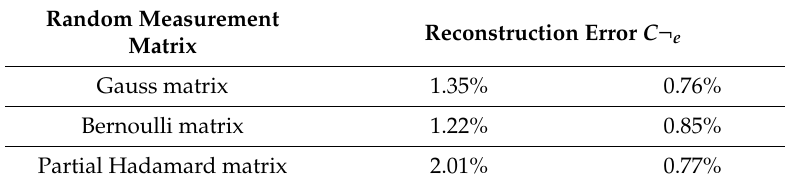
Table 1. The reconstruction error of IGBT switching signal with di ff erent measurement